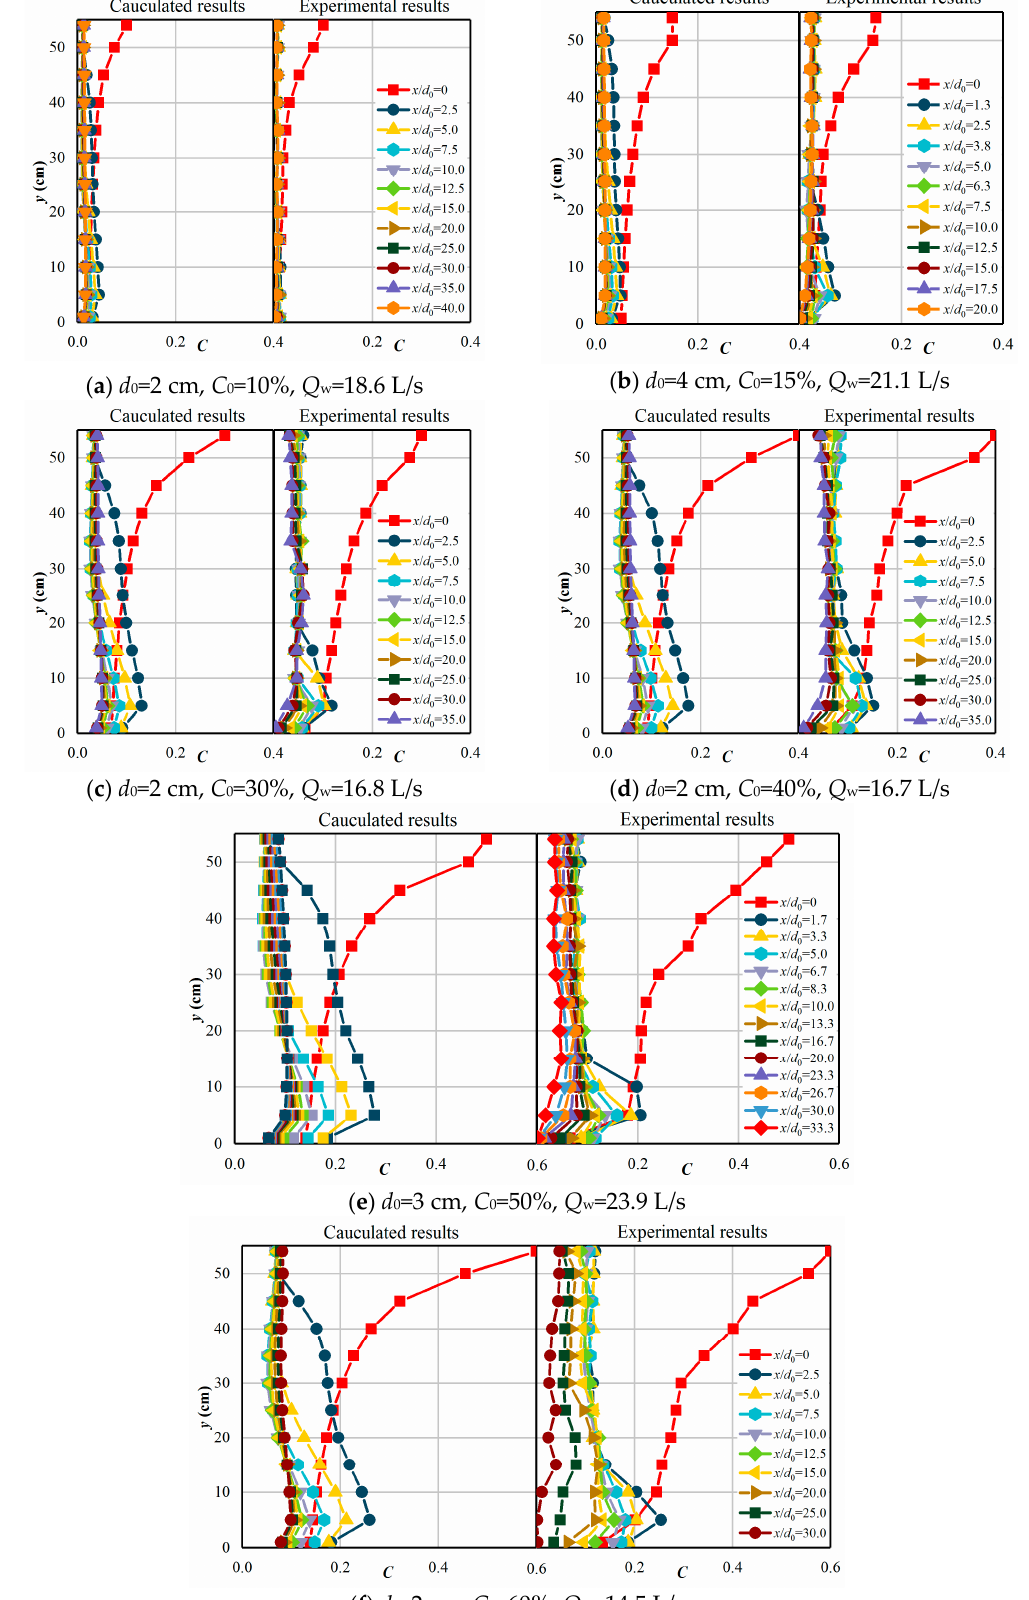
Figure 9. Comparison of calculated and experimental results.